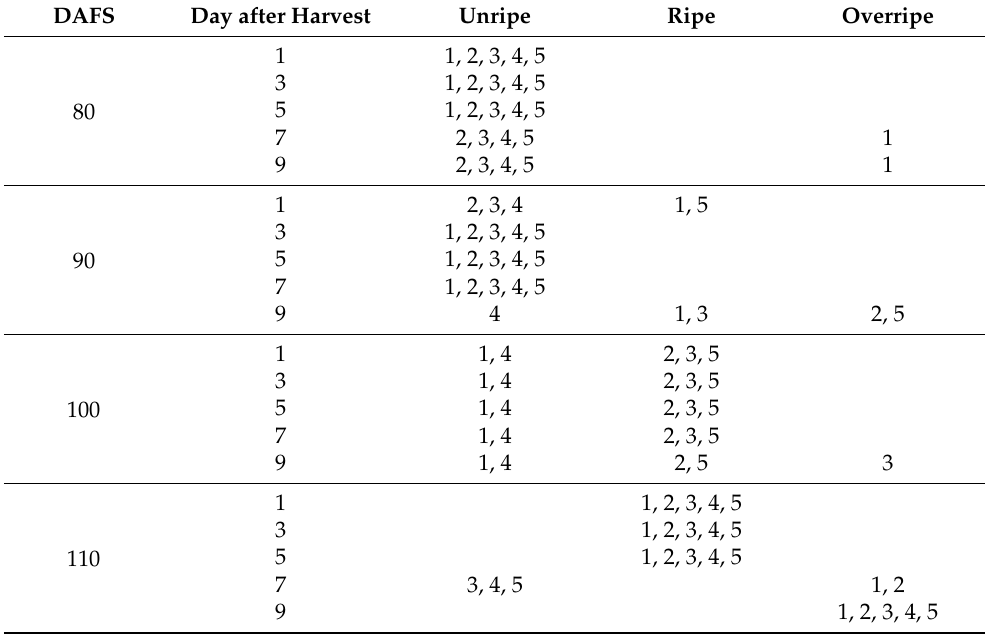
Table 11. Results of the performance of the FANN model after 4-fold cross validation in ripeness classification were tested on the external unseen 20 mangoes for 4 different sets: 80, 90, 100, and 110 days after fruit set. Each set of mangoescontained five mangoes, which were labeled as 1, 2, 3, 4, and 5. DAFS Day after Harvest Unripe Ripe Overripe